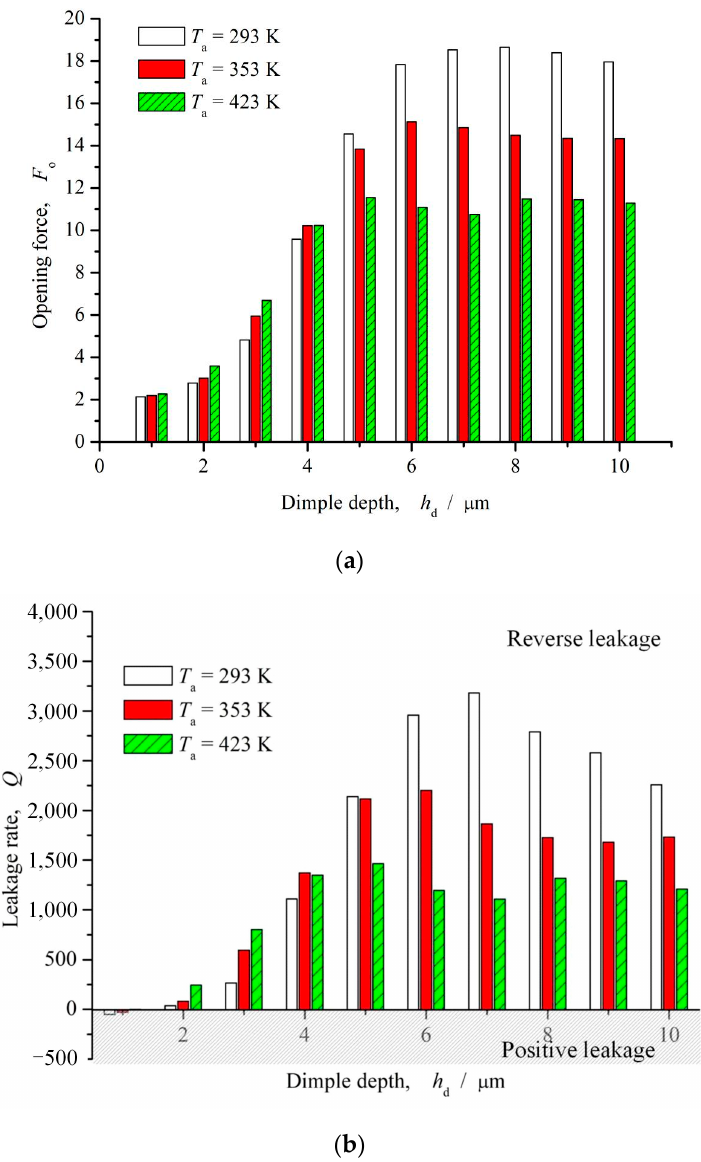
Figure 12. In fl uence of dimple depth on opening force and leakage rate ( ω = 12,000 rpm, P o = 4, h 0 = 2 μ m, γ = 3, α = 45°, N = 80). ( a ) Opening force; ( b ) Leakage